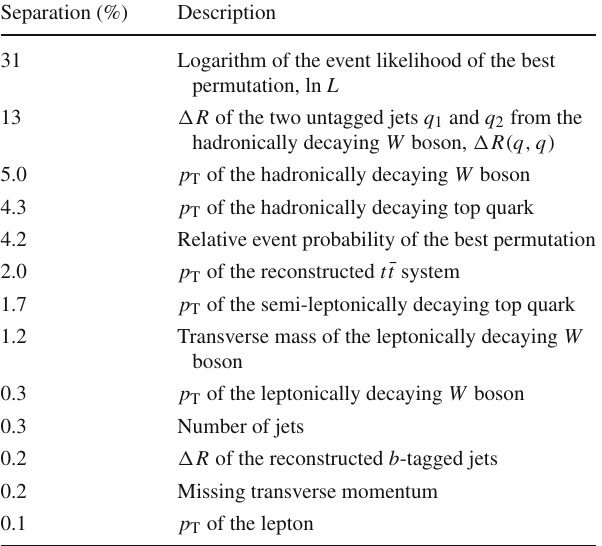
Table 2 The input variables to the BDT algorithm sorted by their sep- aration Separation